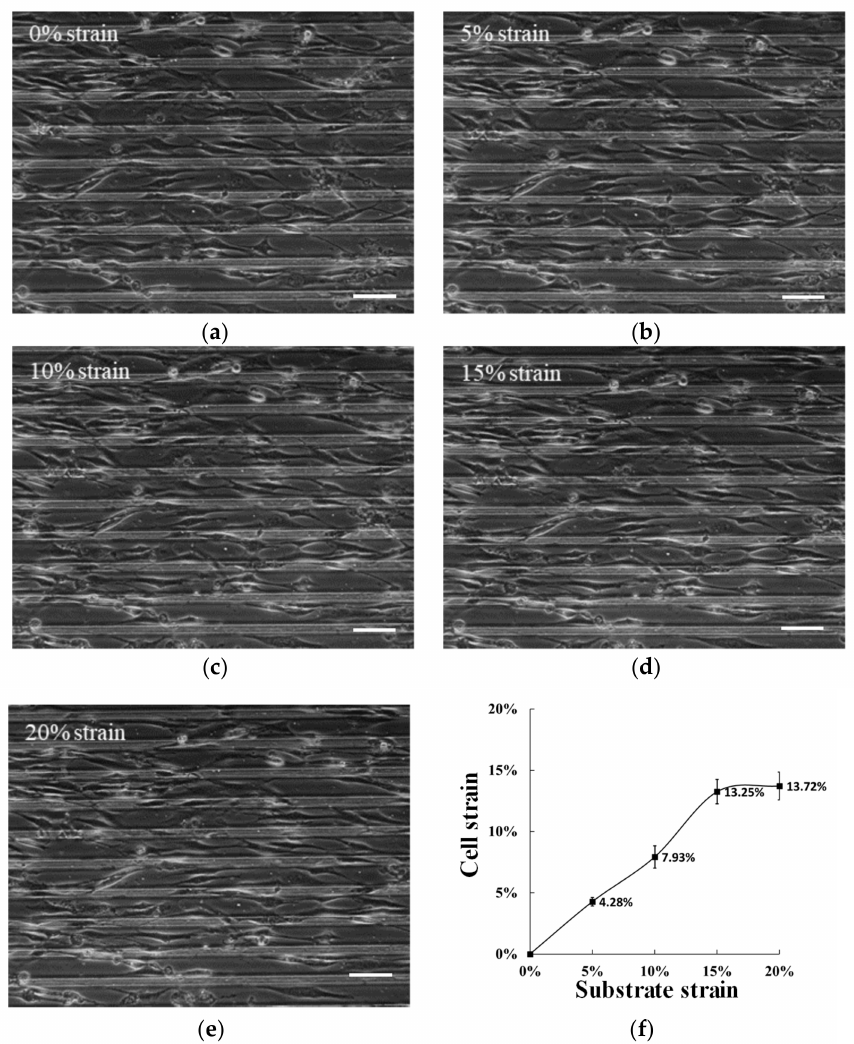
Figure 2. Cell stretching in PDMS culture dish with micro-patterns. The cells were stretched at 0% ( a ), 5% ( b ),10% ( c ), 15% ( d ), and 20% ( e ) strains of the substrate. ( f ) The transmission of PDMS culture dish stretching to the cells (scale bar = 50 µ